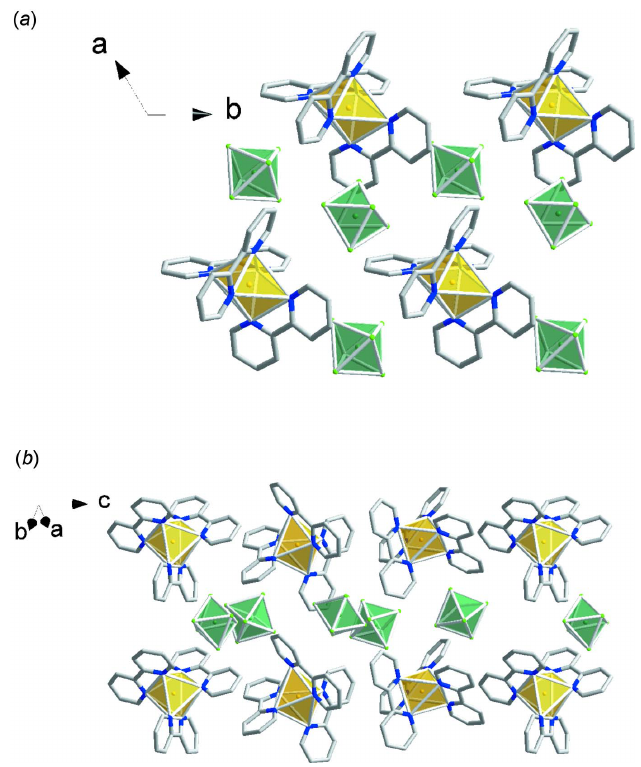
Figure 7 Packing diagram for (III): yellow polyhedra represent Cu(bpy) 32+ cations and green polyhedra represent TaF 6 (cid:3) anions.